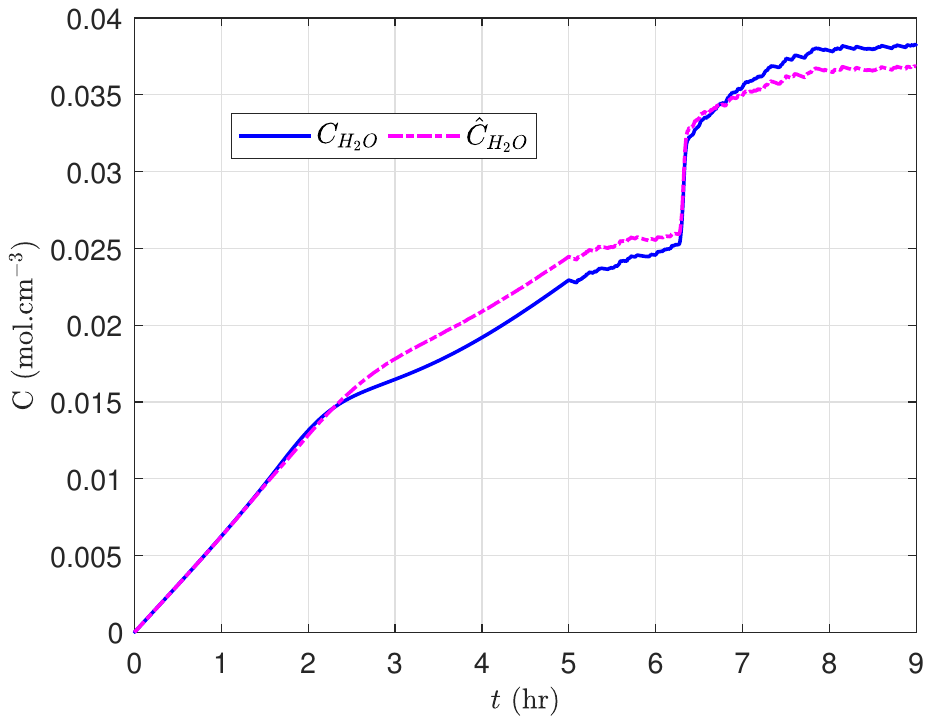
Figure 11. True and estimated steam concentration with